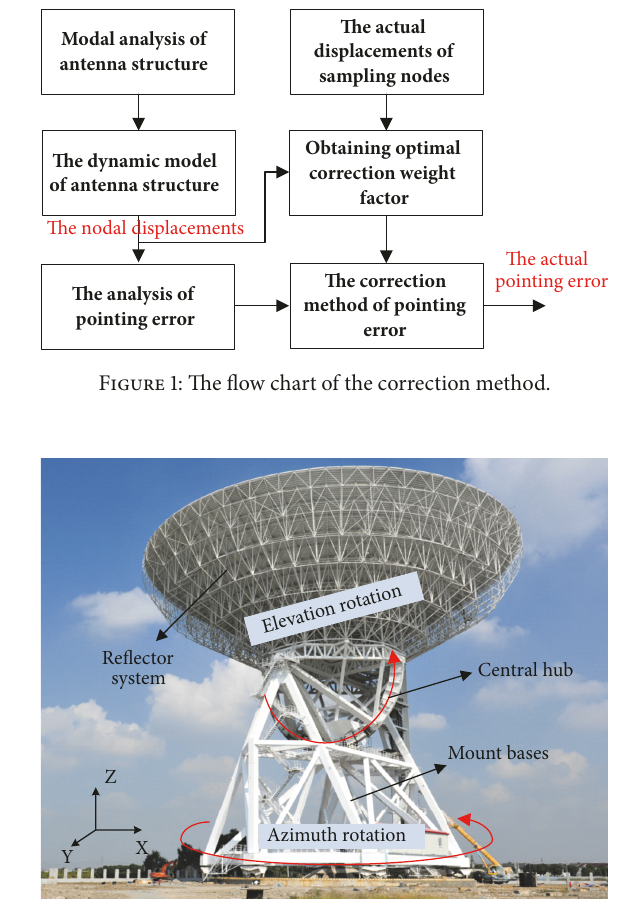
Figure 2: The structure of dual reflector